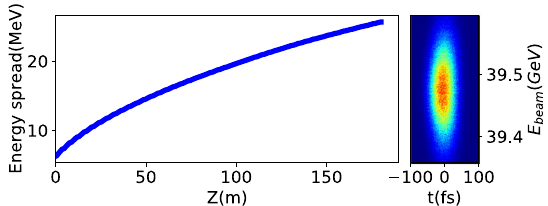
FIG. 10. Left: the evolution of beam energy spread ( σ E ) along the undulator region for 0.5 Å via 40 GeV e-beam energy through planar undulator. Right: longitudinal phase space of e-beam after FEL radiation at 0.5